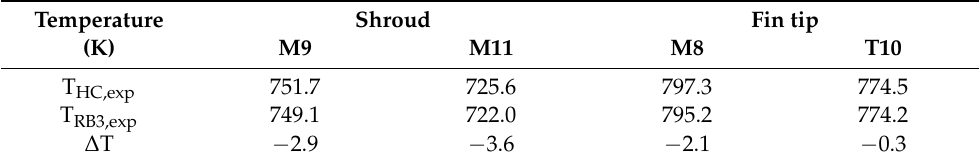
Table 13. Temperature in the labyrinth seal region for test 4 and test 4